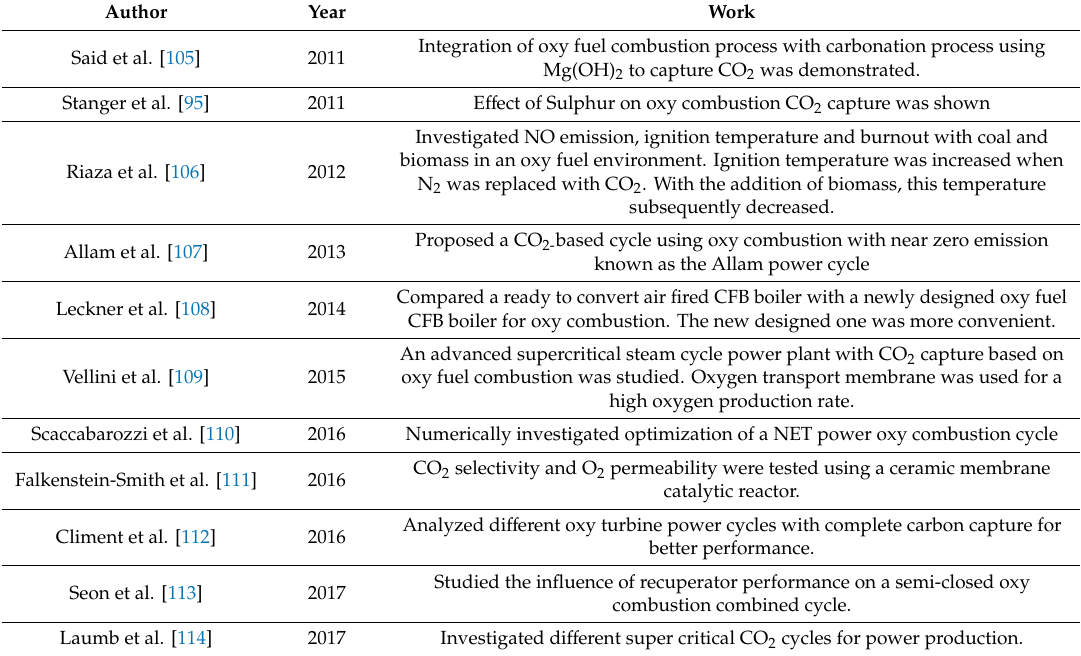
Table 5. Some of the important studies on oxy combustion carbon